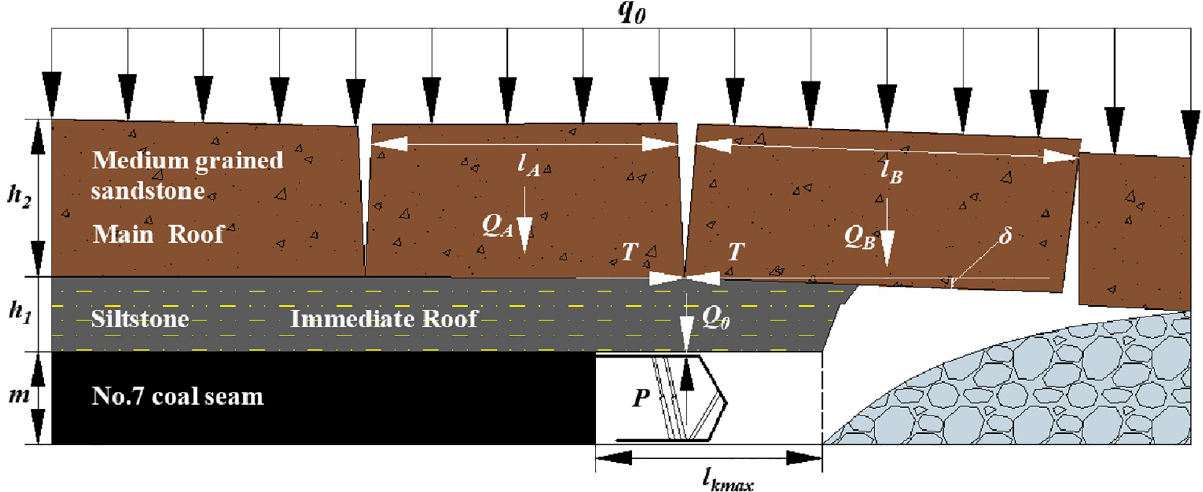
Fig 9. Roof structure characteristic after No.7 coal seam mining.